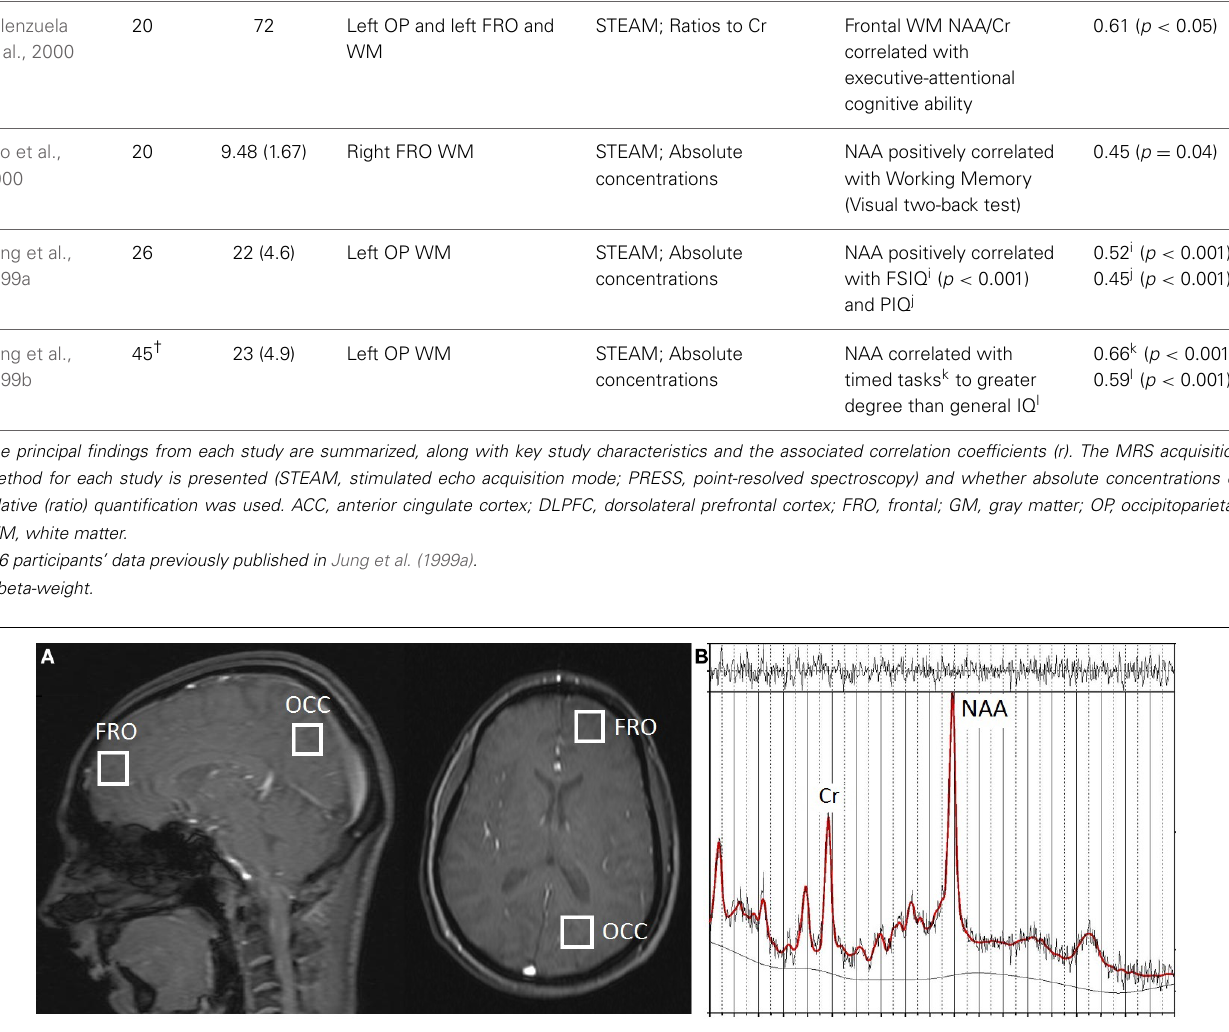
slices at 5mm thickness). (B) Representative 1 H-MRS spectrum from a FRO voxel; Original data shown with the LModeled data overlaid (heavy